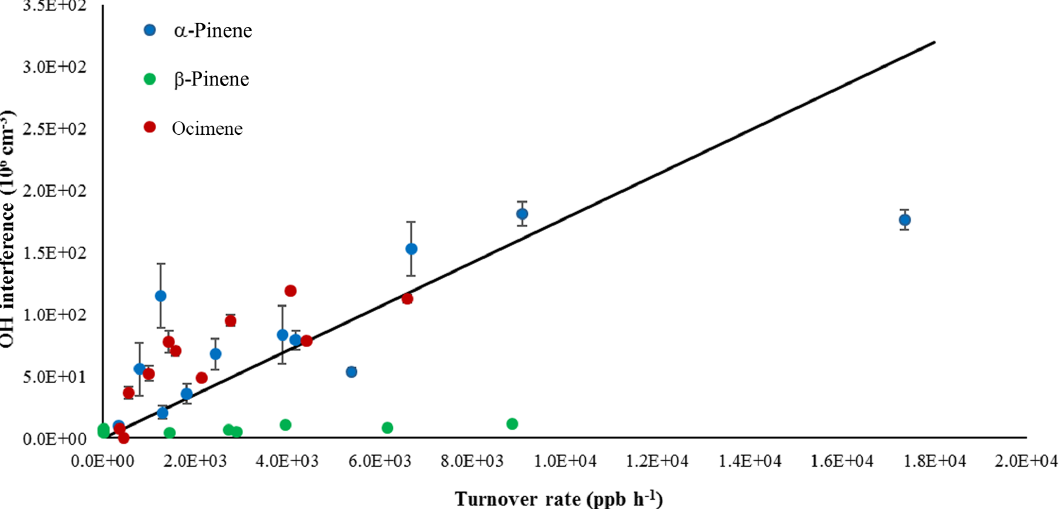
Figure 6. Interference signal as a function of turnover rate for the ozonolysis of α -pinene, β -pinene, and ocimene using the short inlet. Solid line reflects the slope observed by Fuchs et al.